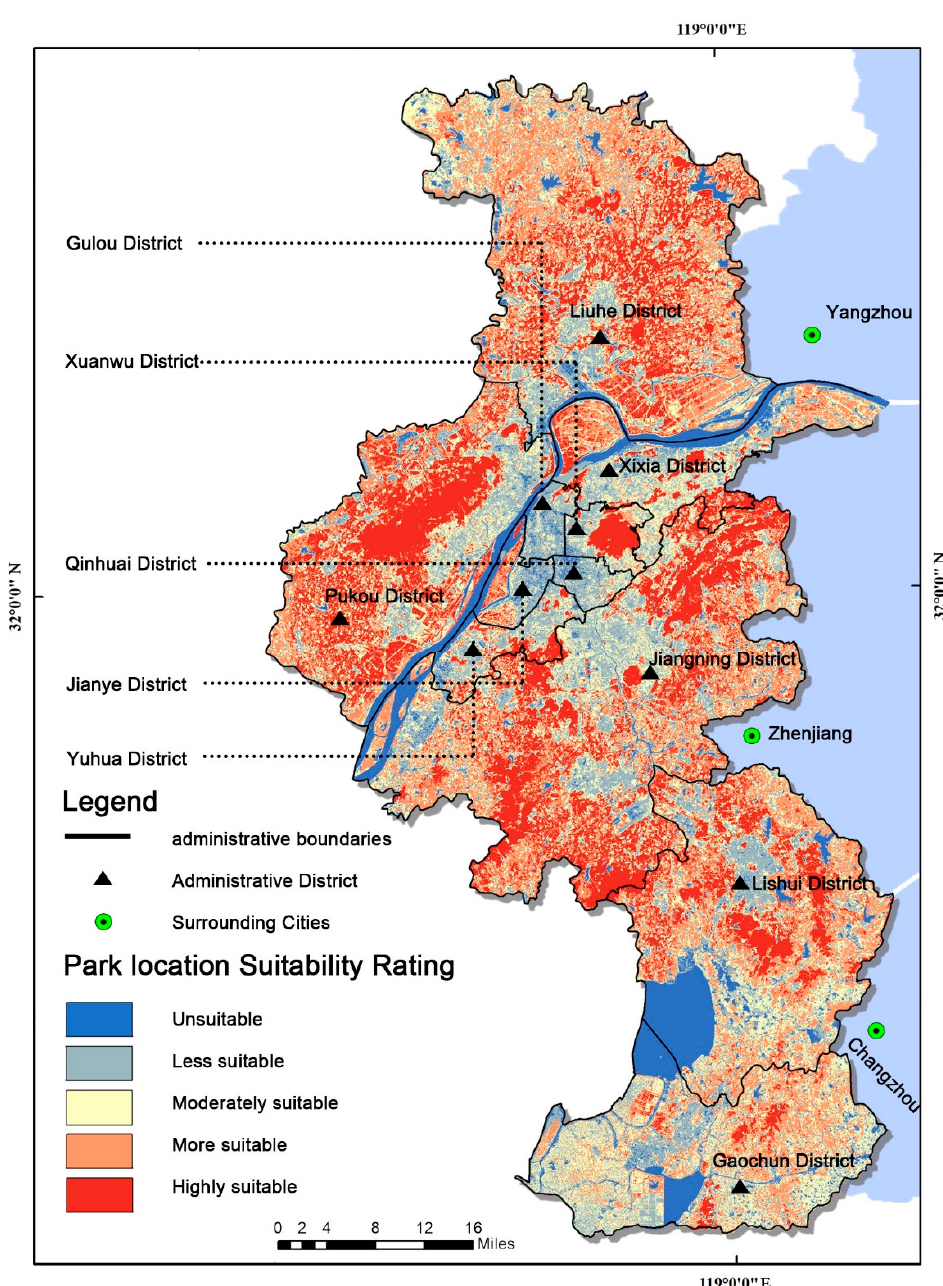
Figure 5. The final map of suitability site selection for urban parks in Nanjing, China. According to the spatial overlay analysis of the 13 criteria, the site selection area was classified as highly suitable, more suitable, moderately suitable, less suitable, and unsuitable. Overall, 21% (1401 km 2 ) were highly suitable for urban park site selection, 28% (1844 km 2 ) were more suitable, 24% (1578 km 2 ) were moderately acceptable, 19% (1223 km 2 ) were less suitable, and 8% (531 km 2 ) were unsuitable for urban park site selection. The most suitable areas for urban park sites were concentrated in the west